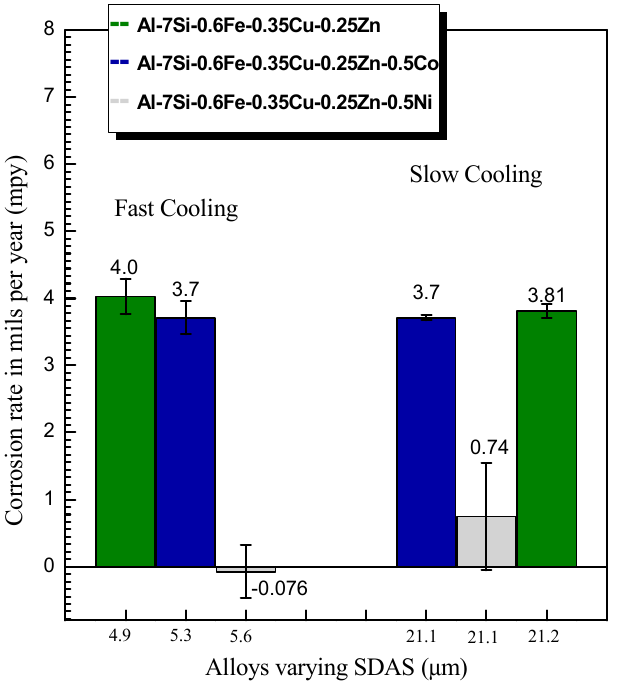
Figure 10. Corrosion rates (mpy) of the Al-7%Si-0.6%Fe-0.35%Cu-0.25%Zn (-Ni, -Co) samples after 30 days immersed in a 0.6 M NaCl solution.